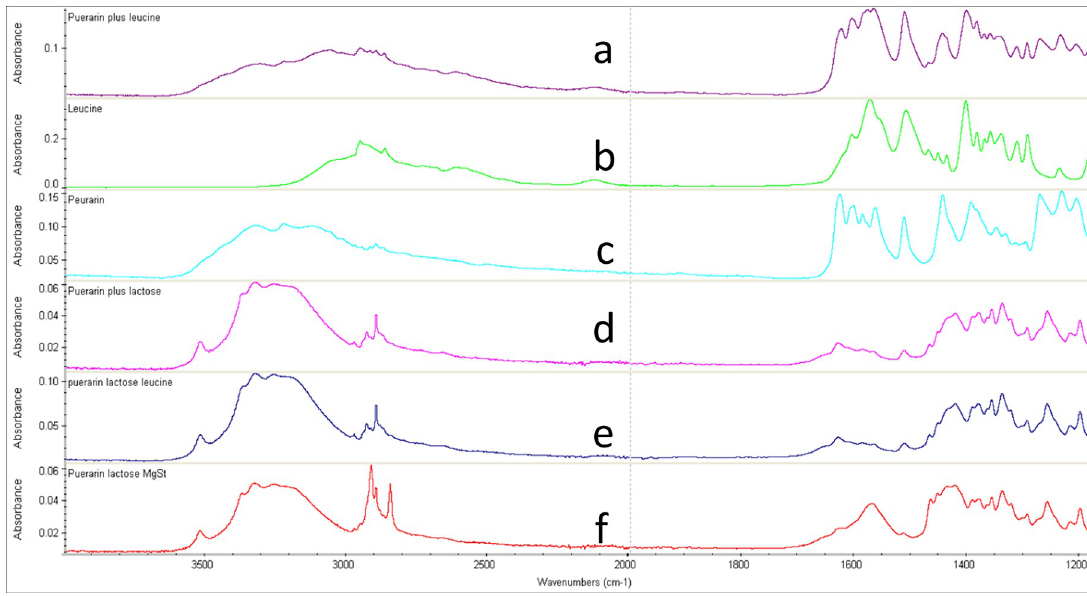
Fig 4. ATR-FTIR of pure puerarin plus leucine (a), Leucine (b), pure puerarin (c), puerarin plus lactose (d), puerarin plus lactose plus leucine (e), and puerarin plus Mg-St (f). https://doi.org/10.1371/journal.pone.0249683.g004 of the lactose particles with Mg-St surrounding it which is expected to help the particle flow freely and detach from the carrier surfaces during inhalation [35]. Other images represent the individual components of the mixture as (B) representing Puerarin, (C) lactose, and (D) MgSt.